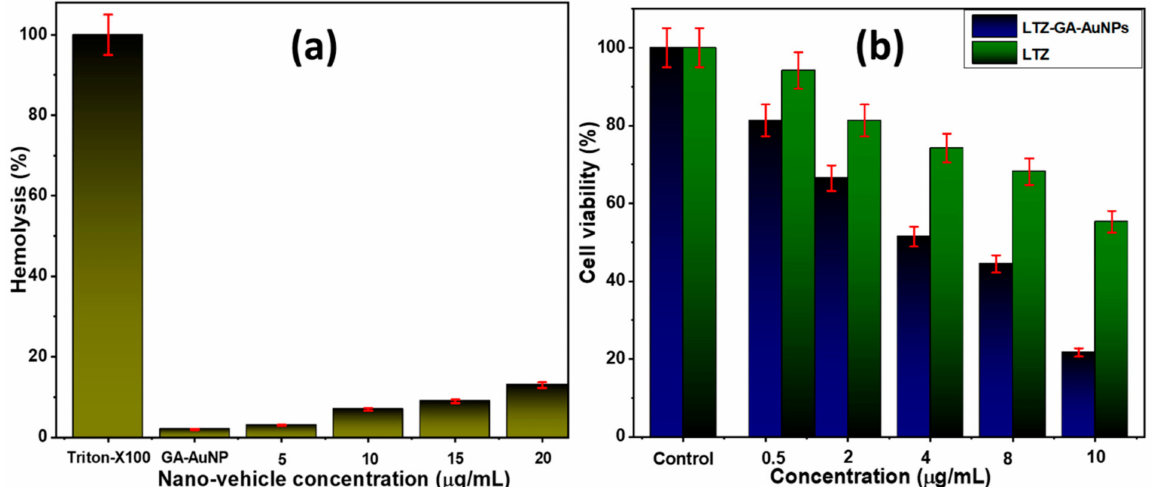
Figure 4. ( a ) In vitro hemolysis percentage of LTZ-GA-AuNPs; ( b ) in vitro cytotoxicity and percent cell viability assay against